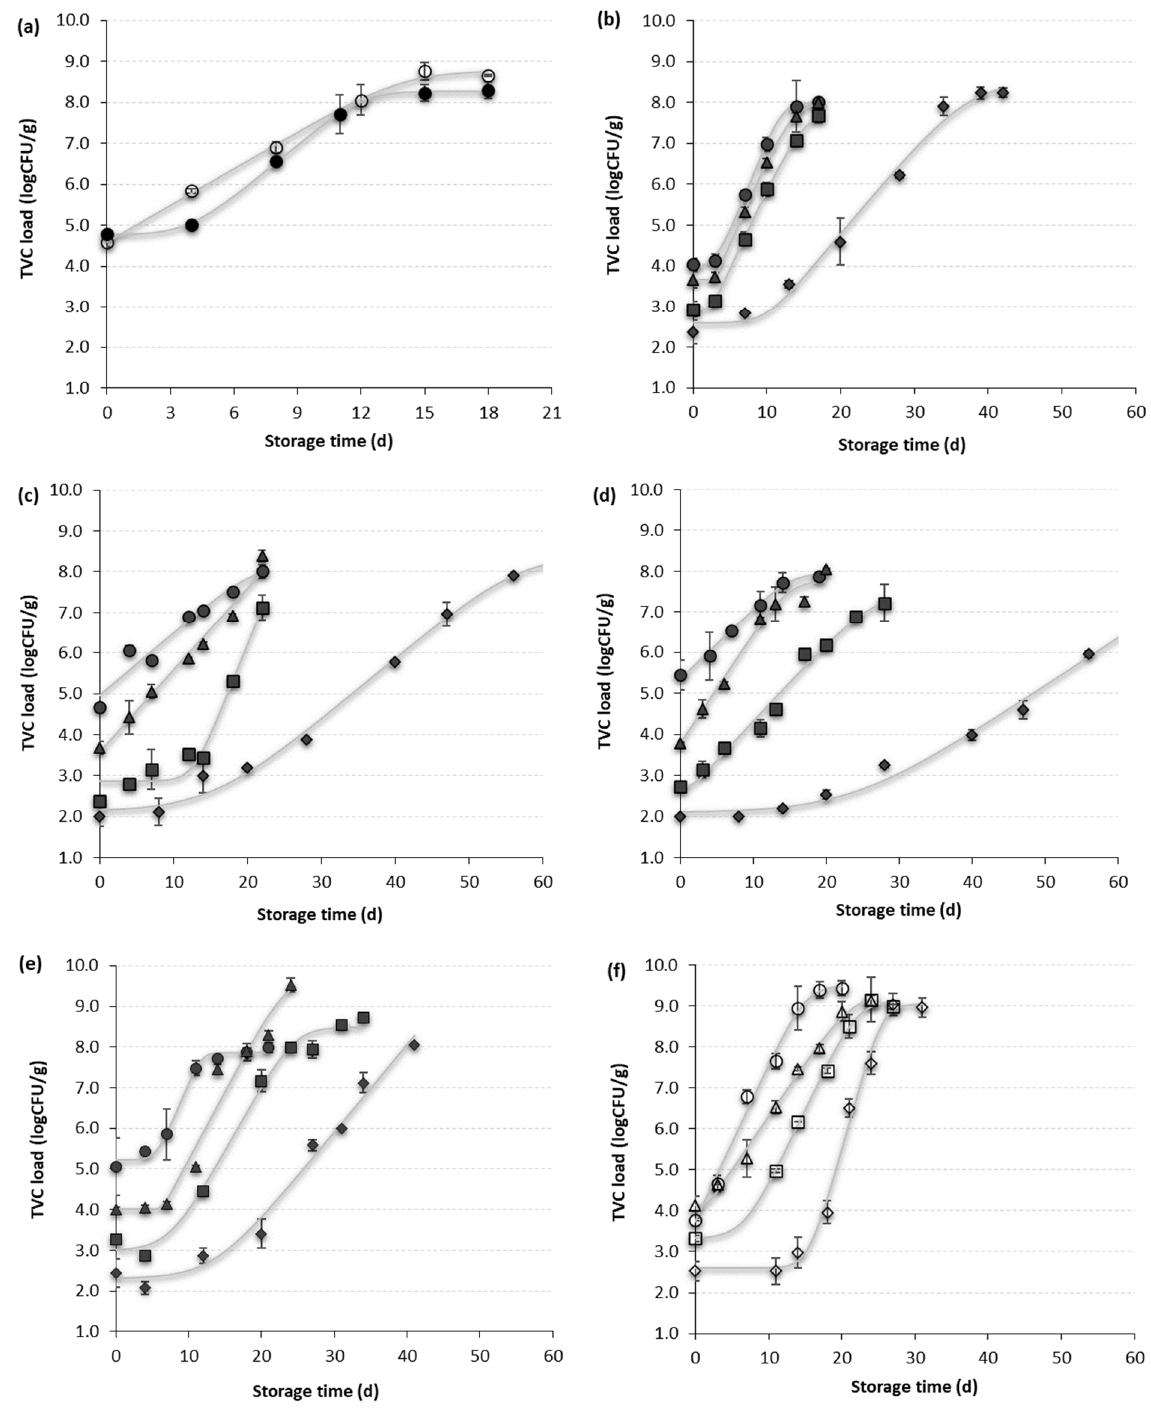
Figure 2. Growth of TVC of ( a ) untreated and HP-treated sea bass fillets at ( b ) 100–400 MPa/3 ◦ C/5 min, ( c ) 100–400 MPa/3 ◦ C/10 min, ( d ) 100–400 MPa/7 ◦ C/10 min, ( e ) 100–400 MPa/25 ◦ C/10 min, and ( f ) 100–400 MPa/25 ◦ C/10 min—stored aerobically. Symbols indicate ( • )—HP at 100 MPa, ( (cid:78) )—HP at 200 MPa, ( (cid:4) )—HP at 300 MPa, and ( (cid:7) )—HP at 400 MPa. Hollow symbols refer to aerobic storage of the fillets, while solid symbols refer to vacuum-packed fillets. Each point shows the mean and the standard deviation of four replicates ( n = 4).